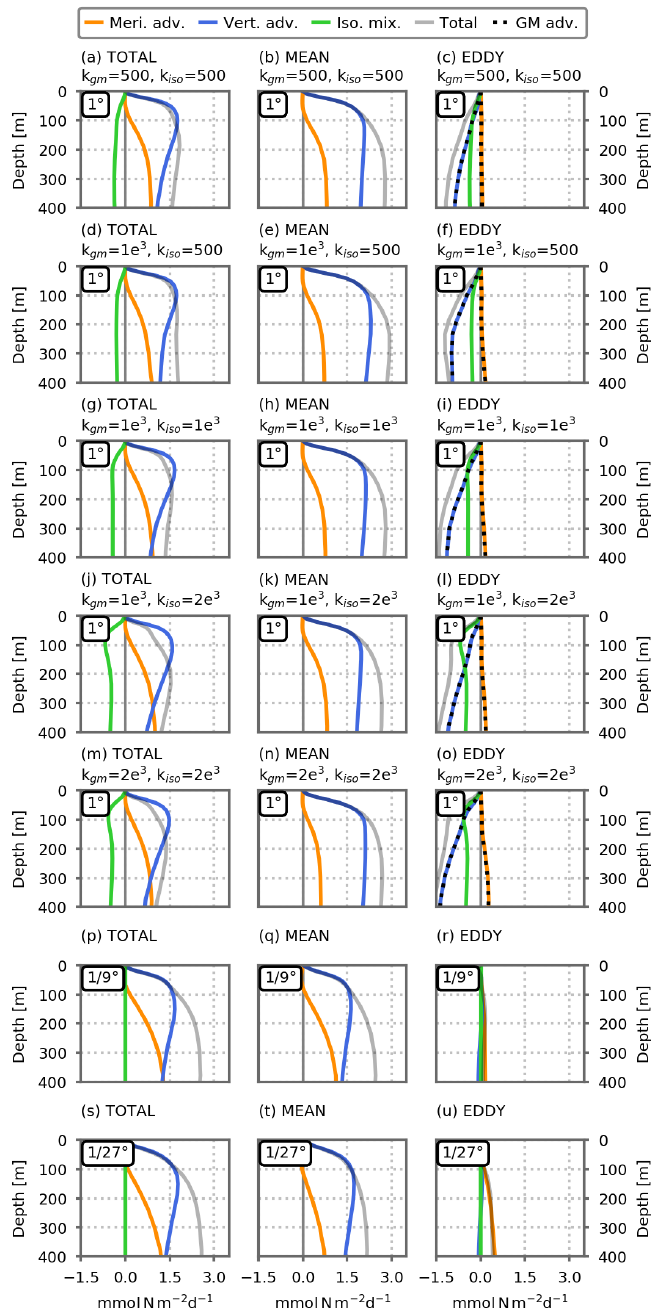
Figure A5. Vertical profiles of dynamical nitrate supplies (mmolNm − 2 d − 1 ) in the model’s subpolar box (dashed black lines in Fig. 3), cumulated between the surface and depth D in the preindustrial control simulations, against D . Total transport (gray lines here, solid blue lines in Fig. 4) is decomposed into three components: in orange, the meridional advective flux at the southern border; in blue, the vertical advective flux at depth D ; and, in green, the isopycnal mixing. For each resolution, the total advective fluxes (first column) are broken into mean and eddy transport terms (the second and third columns, respectively). In the fine-resolution simulations (1 / 9, 1 / 27 ◦ ), they are derived from Reynolds decomposition (see the Methodology section). In the coarse-resolution simulations (CTL1/CC1), the mean transport represents the resolved transport by the coarse-resolution velocity field, and the eddy transport includes the two eddy parameterizations. Panels (a) – (o) show the five 1 ◦ resolution configurations, and (p) – (u) show the 1 / 9 and 1 / 27 ◦ resolution configurations. All figures show the average over the last 5 years of the simulations (years 66 to 70). Positive values indicate an inflow into the subpolar